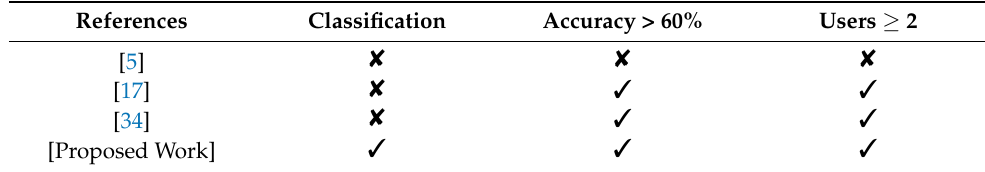
Table 1. Comparison table of related study and proposed work.